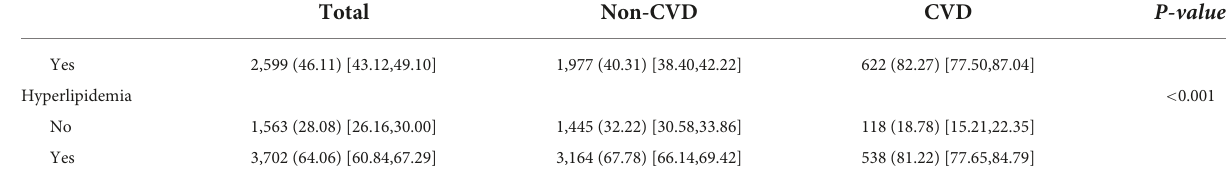
Unweighted Unweighted number of total number of participants